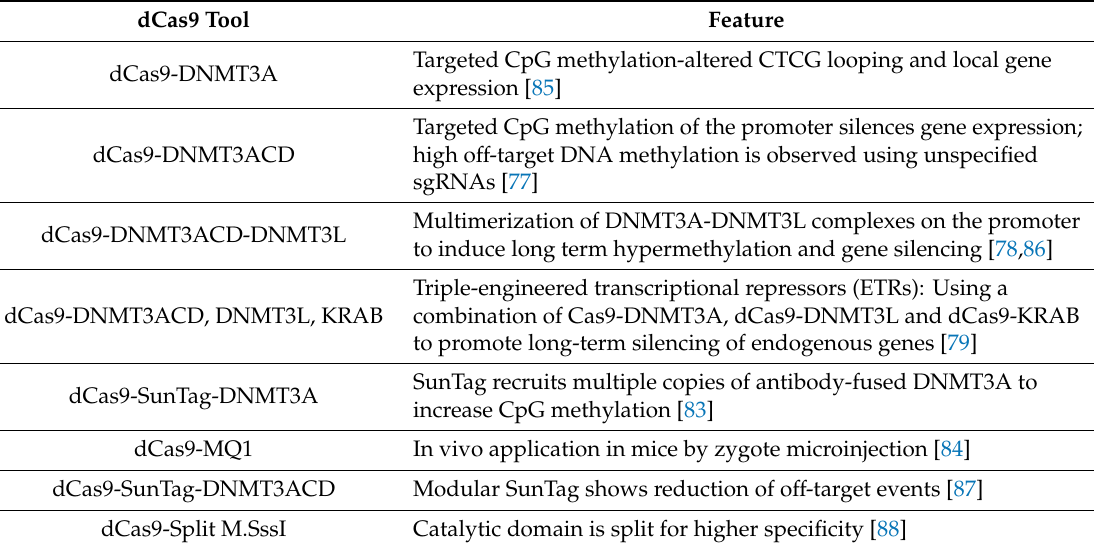
Table 2. Summary of CRISPR-dCas9-based tools for DNA